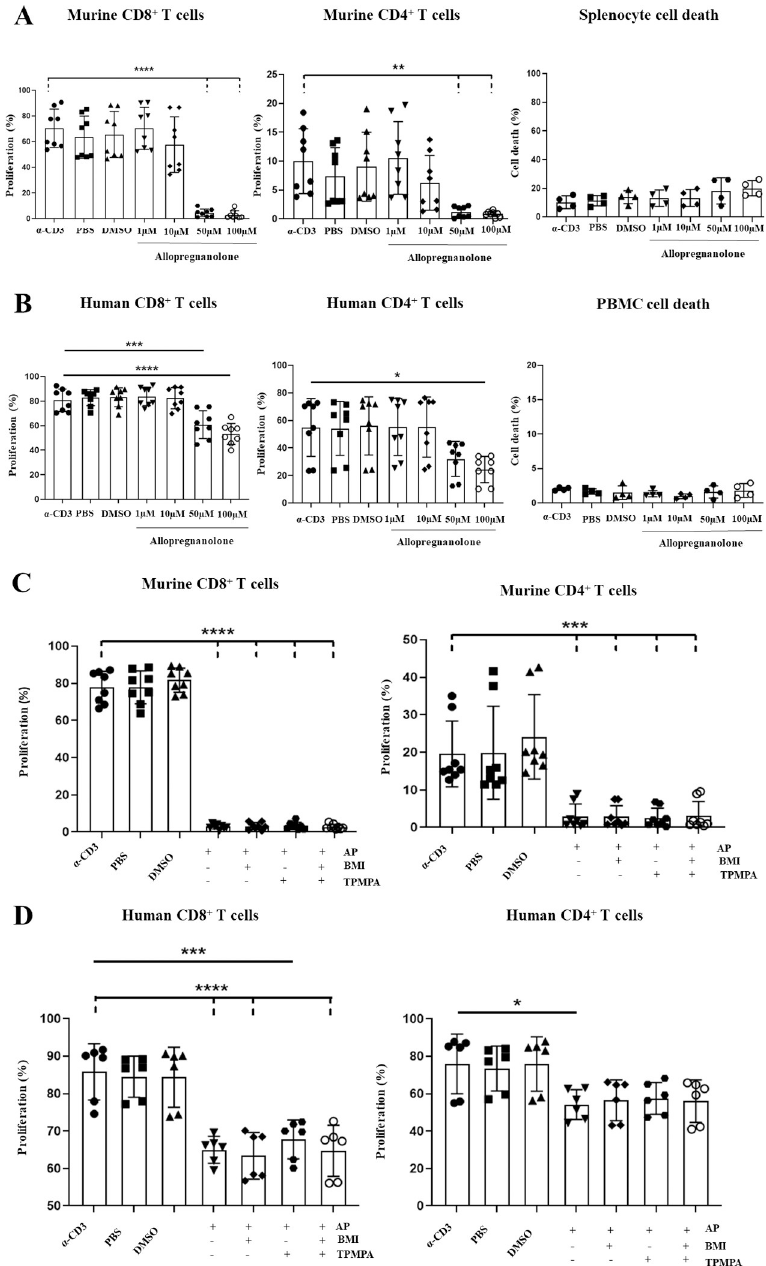
Fig 5. Allopregnanolone inhibits human and mouse T-cell proliferation, which cannot be rescued with GABA(A) R inhibitors. A, B) Allopregnanolone causes a dose dependent inhibition of T cell proliferation in mouse and humans. Splenocytes were isolated from the spleens of female wildtype BALB/c mice, and PBMCs were isolated from human whole blood samples. Cells were stained with 5 μ M CFSE, before being treated with soluble α -CD3 antibody (33 ng/ml for splenocytes, 100 pg/ml for PBMCs), in addition to either 1 μ M, 10 μ M, 50 μ M or 100 μ M allopregnanolone. Splenocytes were harvested following 48 hours of treatment, while PBMCs were harvested following 96 hours of treatment. The percentage of proliferating T cells in each condition was determined by flow cytometry through assessing the reduction in CFSE fluorescence as compared to a positive control of α -CD3 treatment alone. A . Dose dependent inhibition of CD8 + and CD4 + T cell proliferation by allopregnanolone in treated splenocytes, in addition to total splenocyte death in response to allopregnanolone treatment. B . Dose dependent inhibition of CD8+ and CD4+ T cell proliferation by allopregnanolone in treated PBMCs, in addition to total PBMC death in response to allopregnanolone treatment. C, D ) Treatment with a combination of BMI and TPMPA cannot rescue allopregnanolone induced inhibition of proliferation in mice or humans. Splenocytes and PBMCs were treated with α -